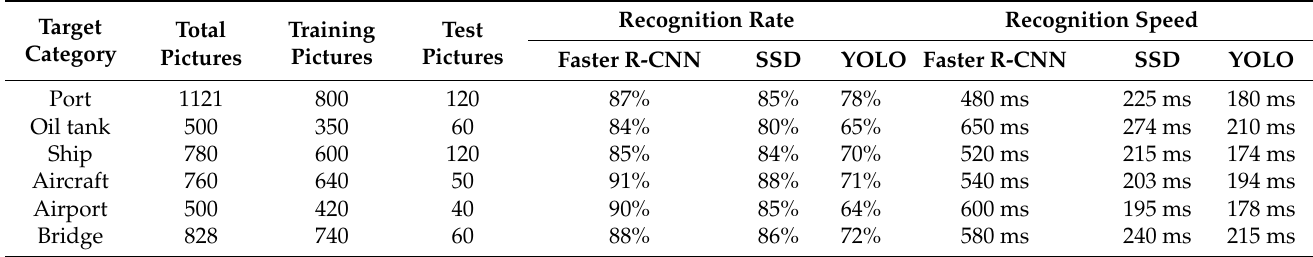
Table 3. Verification of self-built dataset target detection network performance.